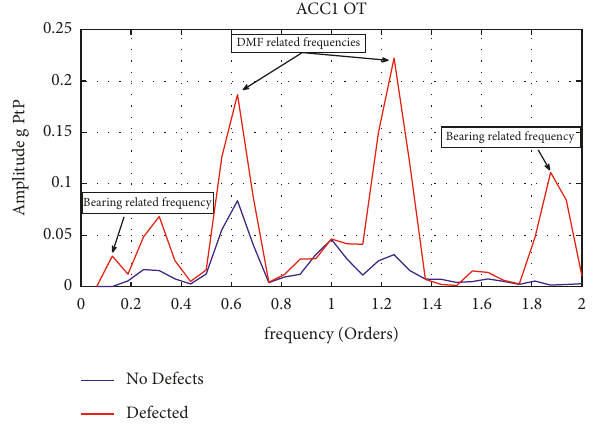
Figure 19: Noncyclostationary with damage.